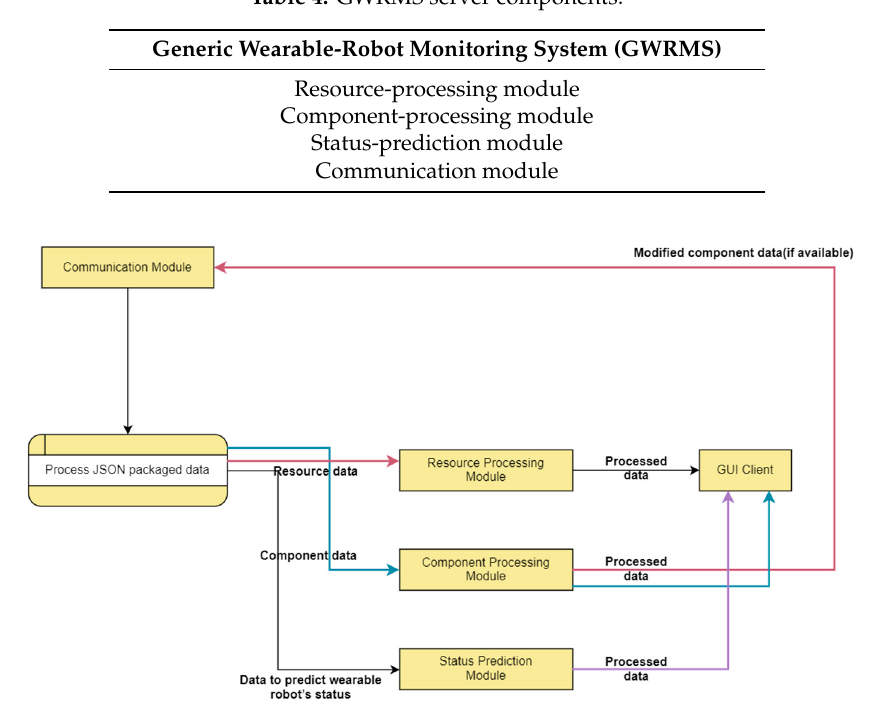
Table 4. GWRMS server components.